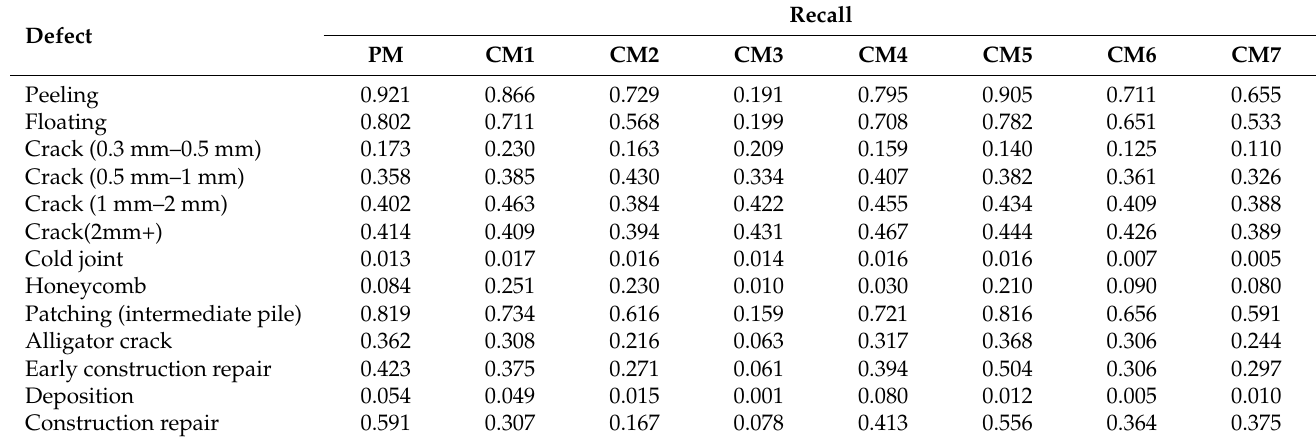
Table 4. Recall of all kinds of defects in each